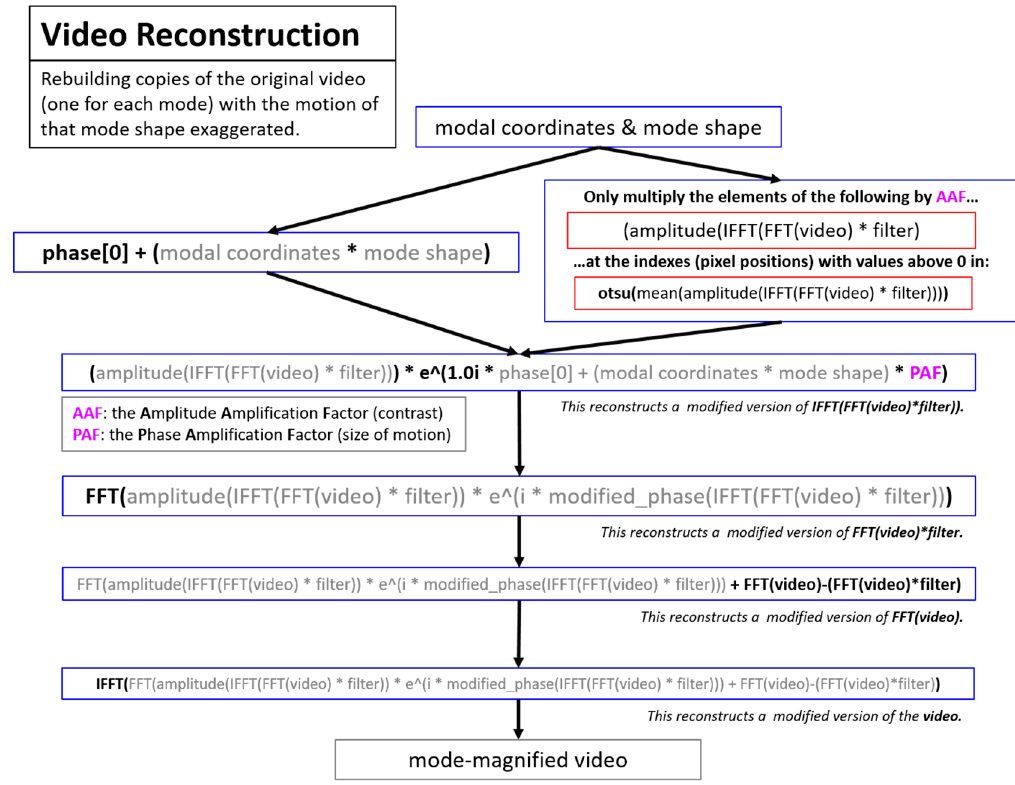
Figure 7. Overview of the process to perform motion magnification to visualize the mode shapes. This process is heavily inspired by the motion magnification process found in [52].